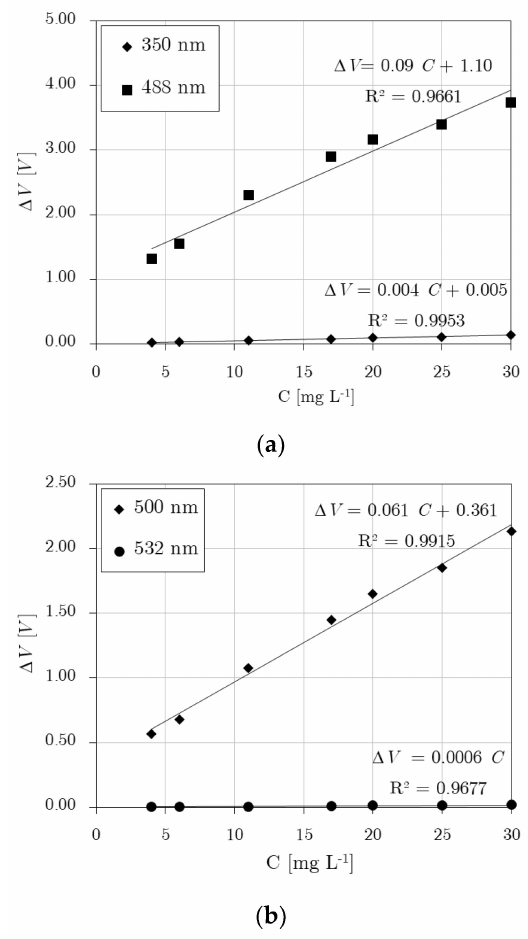
Figure 3. Electric potential difference for fluorescein versus concentration at different excitation light wavelengths in H 3 PO 4 0.100 M + NaOH 0.165 M medium, pH = 7 @25 ◦ C for ( a ) 350 and 488 nm and ( b ) 500 and 532